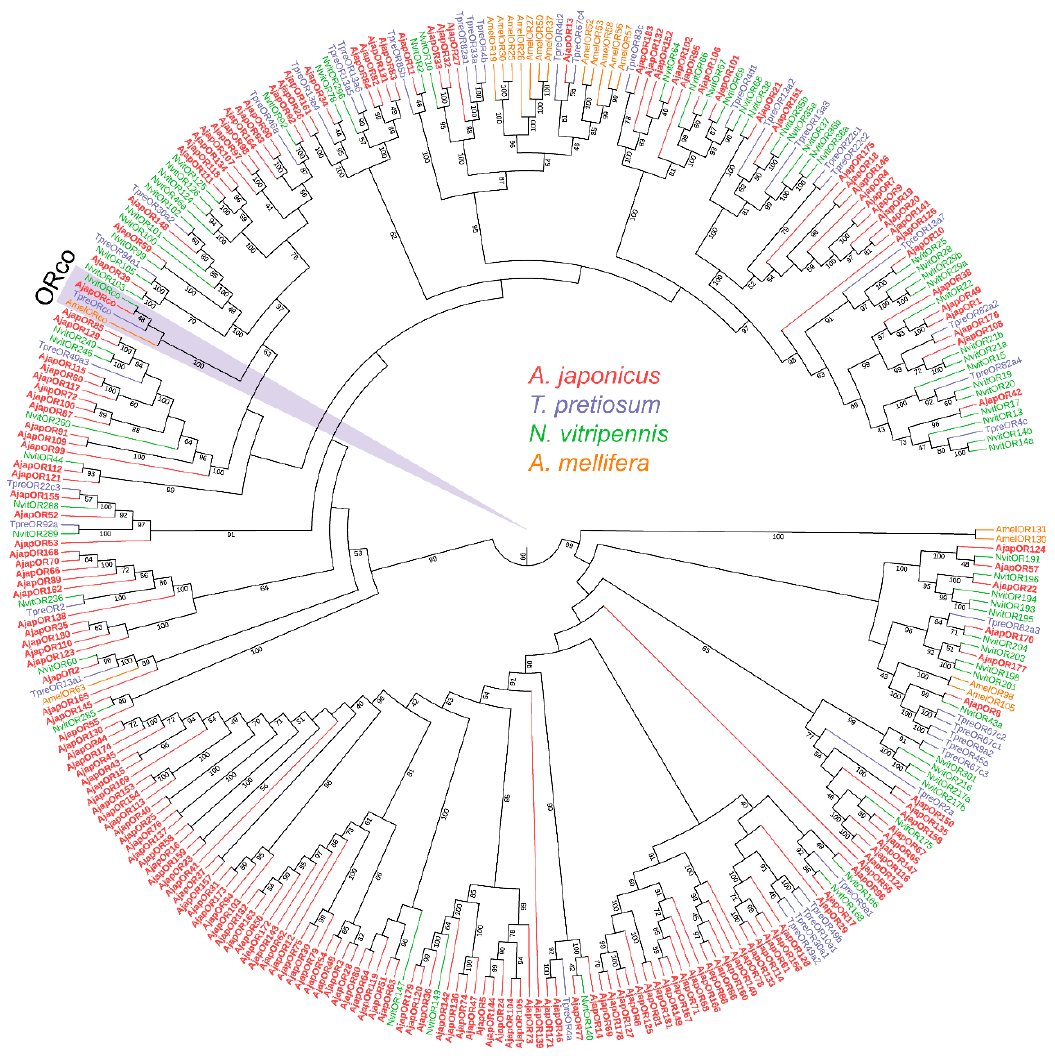
Figure 1. Phylogenetic tree of odorant receptors (ORs). Ajap: Anastatus japonicus (red); Tpre: Trichogramma pretiosum (purple); Nvit: Nasonia vitripennis (light green); Amel: Apis mellifera (orange). Numbers at nodes represent support values higher than 40, where 100 represents maximal support.